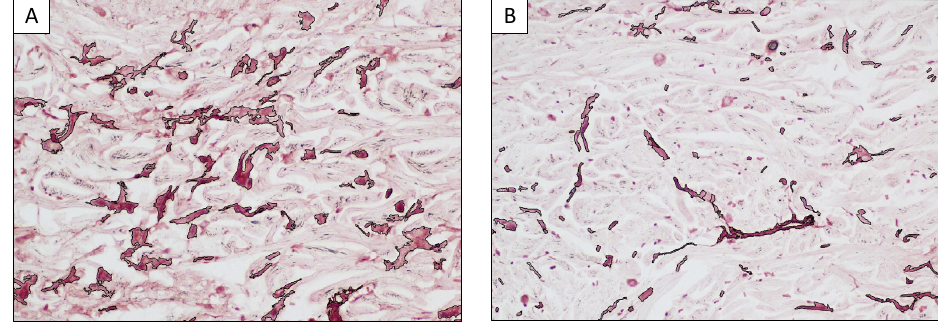
Figure 2. Representative example of morphometric analysis. The area occupied by elastotic material was assessed for each field over a total area of 0.27 mm 2 . ( A ) Dermis adjacent to the lesions. ( B ) Dermis far from the lesions in a less UV-exposed area.